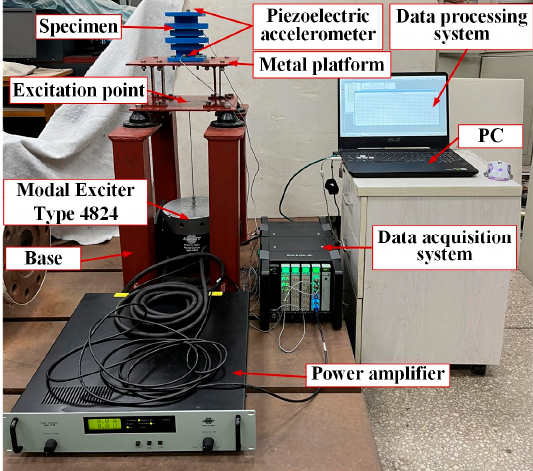
Figure 7. Exciter experiment process block diagram.